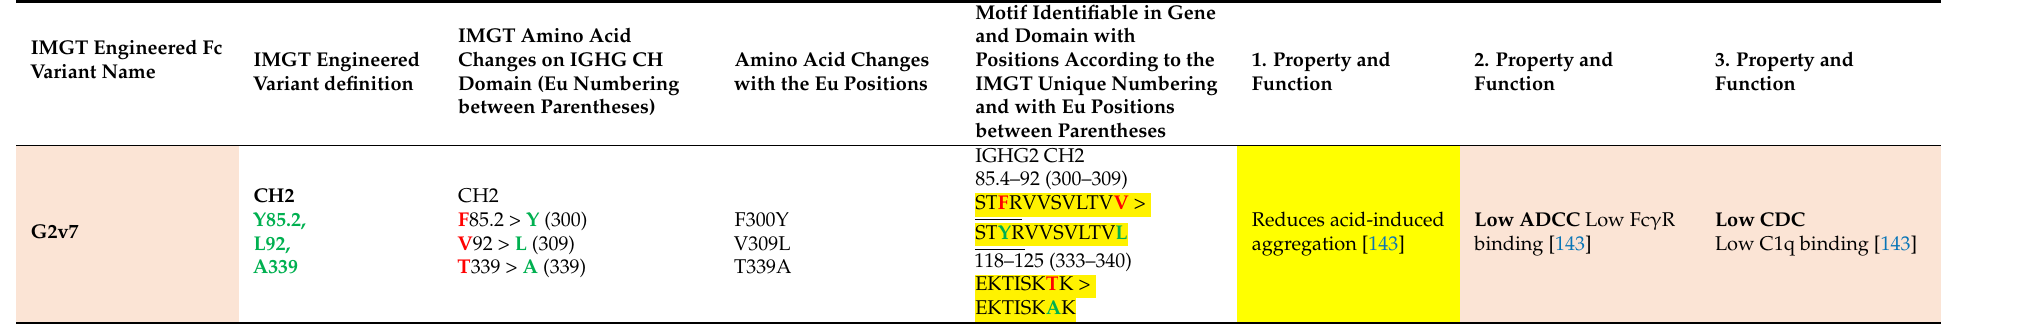
Table 23. IMGT nomenclature, Eu positions and IMGT motif of engineered Fc variants involved in reducing acid-induced aggregation (Structure